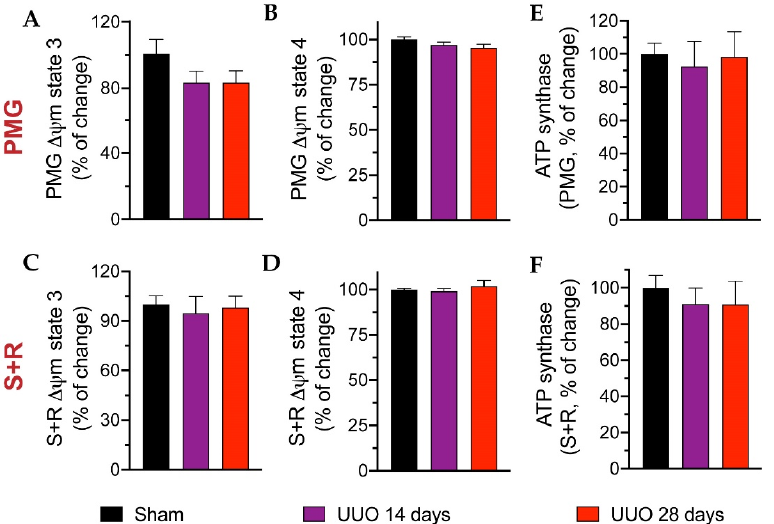
Figure 5. Mitochondrial integrity and ATP synthase activity in cardiac mitochondria isolated from unilateral ureteral obstruction (UUO) animals for 14 and 28 days. Data related to transmembranal potential ( ∆Ψ m) using substrates for Complex I (CI) at ( A ) state 3 (S3) and ( B ) state 4 (S4), and for Complex II (CII) at ( C ) S3 and ( D ) S4. ATP synthase activity using ( E ) pyruvate-malate-glutamate (PMG) and ( F ) succinate + rotenone (S + R) substrates, respectively. Data represent the mean ± SEM of 4–5 independent